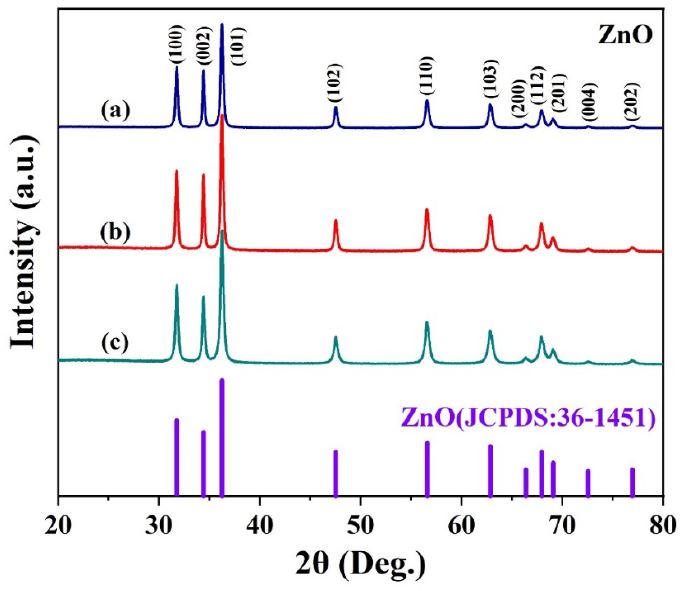
Figure 2. XRD patterns of ZnO nanosheet flowers assisted by different concentrations of malic acid : ( a ) 11 mmol, ( b ) 15 mmol, ( c ) 18 mmol. ( a ) 11 mmol, ( b ) 15 mmol, ( c ) 18